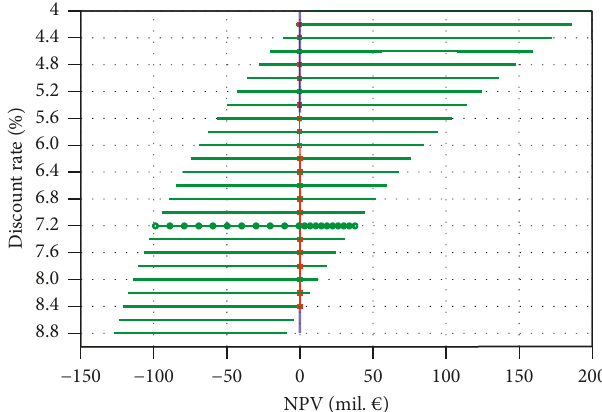
Figure 7: Aerial view of 3D fNPV graph for the motorway.